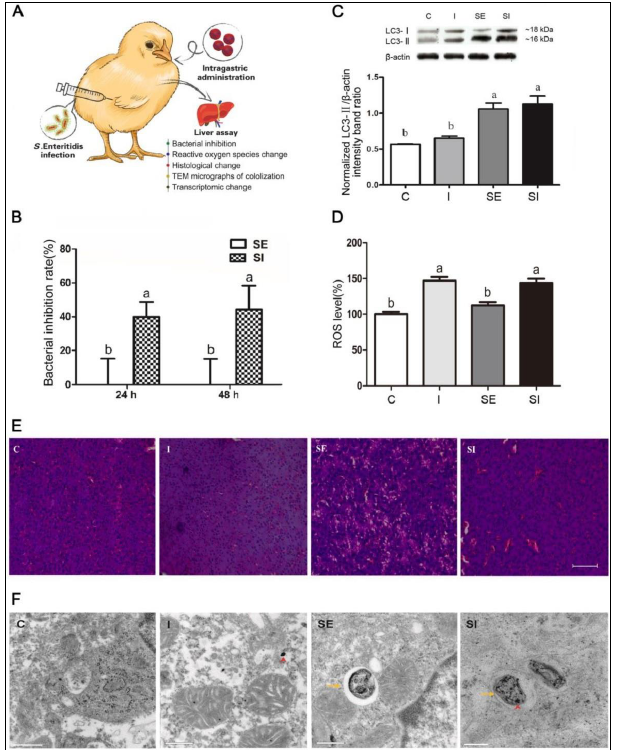
Figure 2. Iron-oxide nanozyme (IONzyme) with peroxidase-like activity in the treatment of chickens infected with S. Enteritidis . Study groups: vehicle control ( C ); IONzyme alone (I); S. Enteritidis without (SE) or with (SI) IONzyme: ( A ) schematic illustration of the experiment in chickens, which were subcutaneously administered with the bacteria and orally administered with IONzymes; ( B ) bacterial inhibition in infected livers, without and with IONzyme treatment, at 24 and 48 h post-treatment; values represent the mean ± SEM ( n = 9). Different letters indicate statistically significant difference ( p < 0.05).; ( C ) Western blot analysis showing normalized hepatic LC3 protein expression levels for the various study groups; the values represent the mean ± SEM ( n = 3). Different letters indicate statistically significant difference ( p < 0.05); ( D ) the relative levels of ROS in various study groups; values represent the mean ± SEM ( n = 6). Different letters indicate statistically significant difference ( p < 0.05); ( E ) photomicrographs of the liver histological sections for the various study groups; scale bar: 50 µ m; ( F ) TEM micrographs showing bacterial co-localization with IONzymes within autophagosomes of chicken liver. IONzyme: red short triangle arrow; S. Enteritidis: yellow arrows. Scale bar: 0.5 µ m (in C, I, SE) and 0.2 µ m (SI). Reprinted with permission from Ref. [39]. Copyright 2018